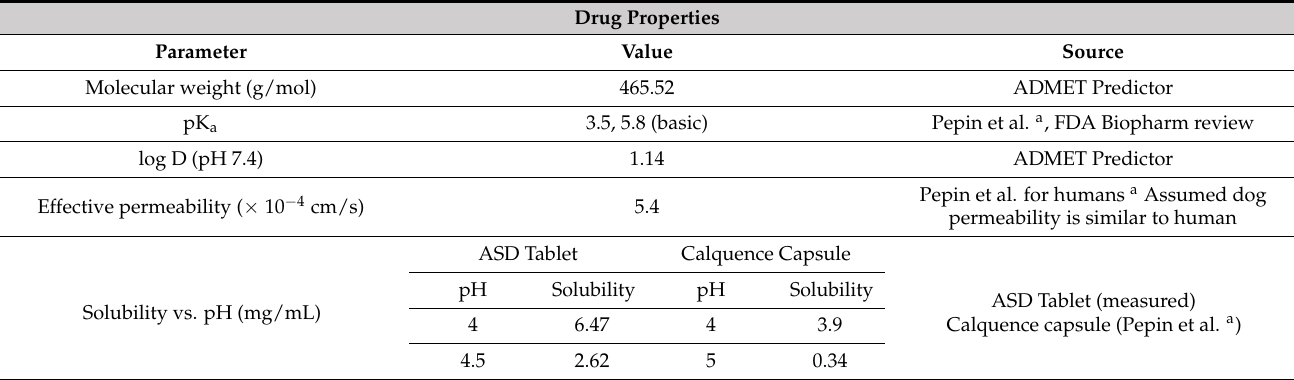
Table 2. Summary of in silico prediction input parameters used for simulating blood plasma concentration versus time profiles of acalabrutinib in beagle